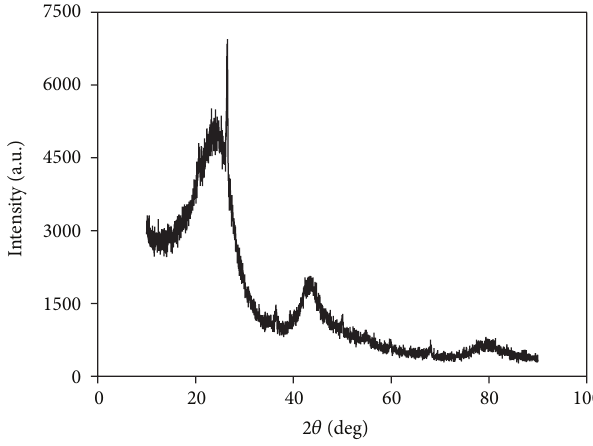
Figure 3: XRD pattern of MnO 2 -impregnated GAC.